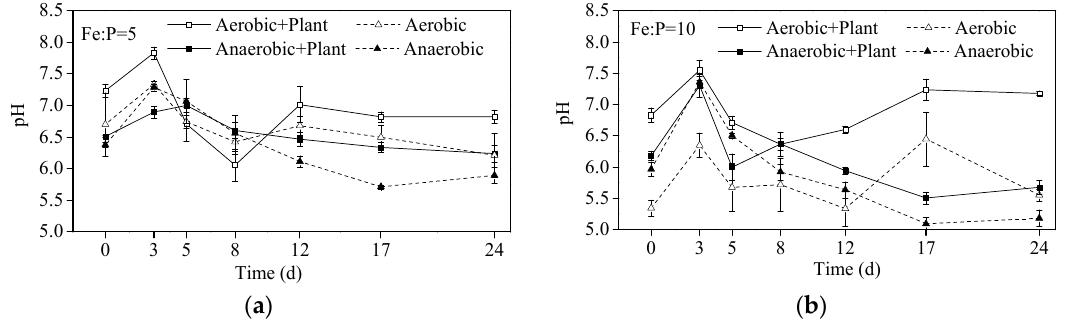
Figure 2. Variation of pH in the overlying water. ( a ) Fe:P = 5; ( b ) Fe:P = 10